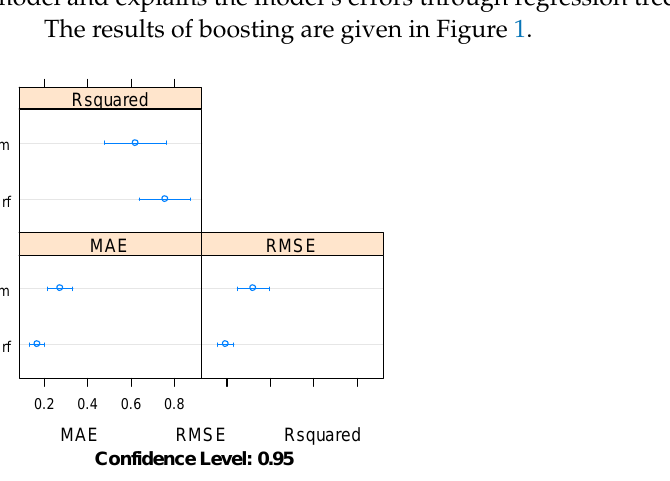
Figure 1. The predictive accuracy of boosting.